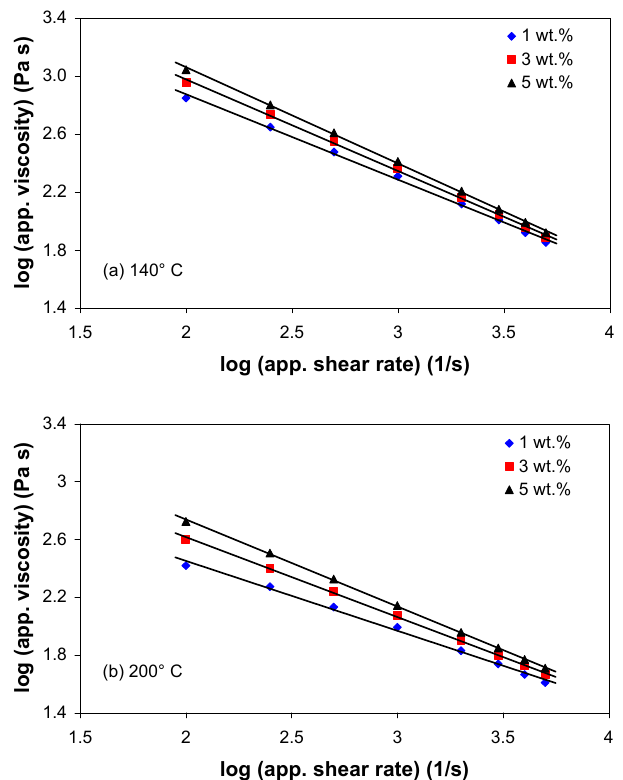
Figure 2. Melt shear viscosity curves at ( a ) 140 °C and ( b ) 200 °C melt temperatures.